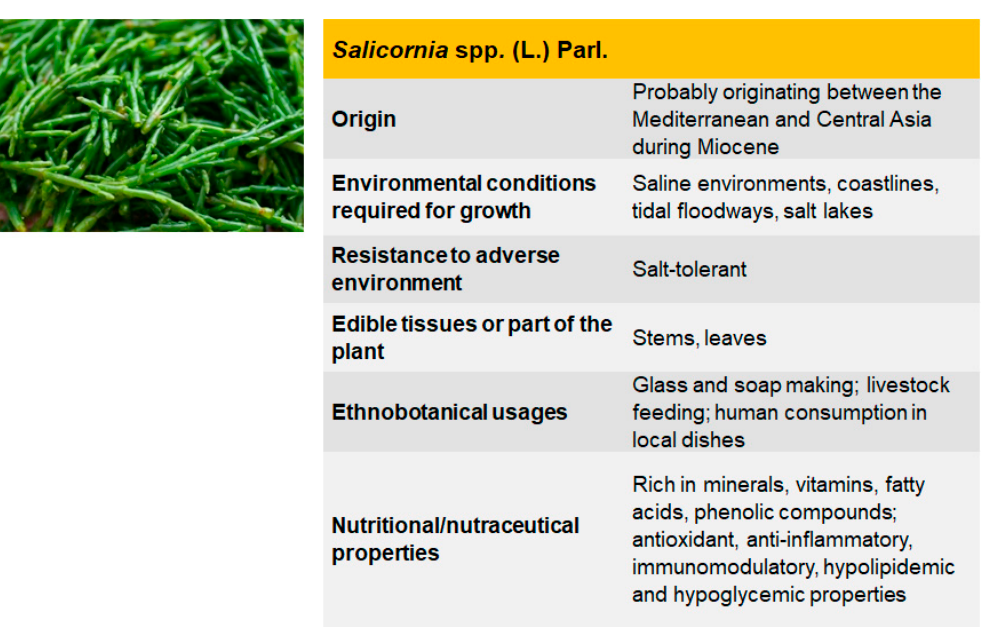
Figure 3. Scheme of the main features of Salicornia spp. (Source photo: biodiversitàpuglia.it [35]). Table 3. Some examples of polyphenol and fatty acid content in Salicornia spp.